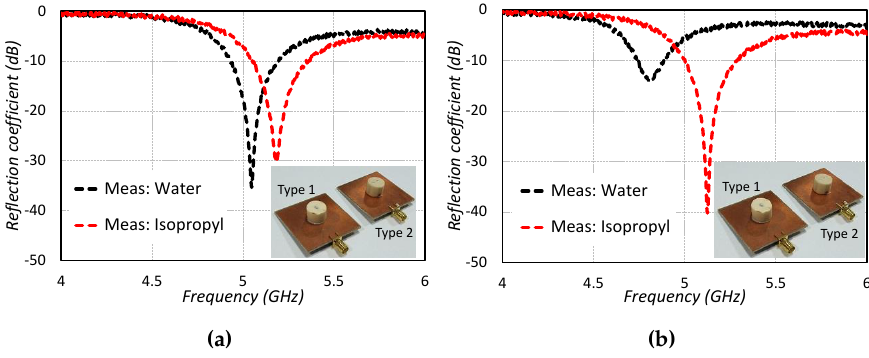
Figure 9. Measured results for CDRA sensor ( a ) Type 1 sensor ( b ) Type 2 sensor.